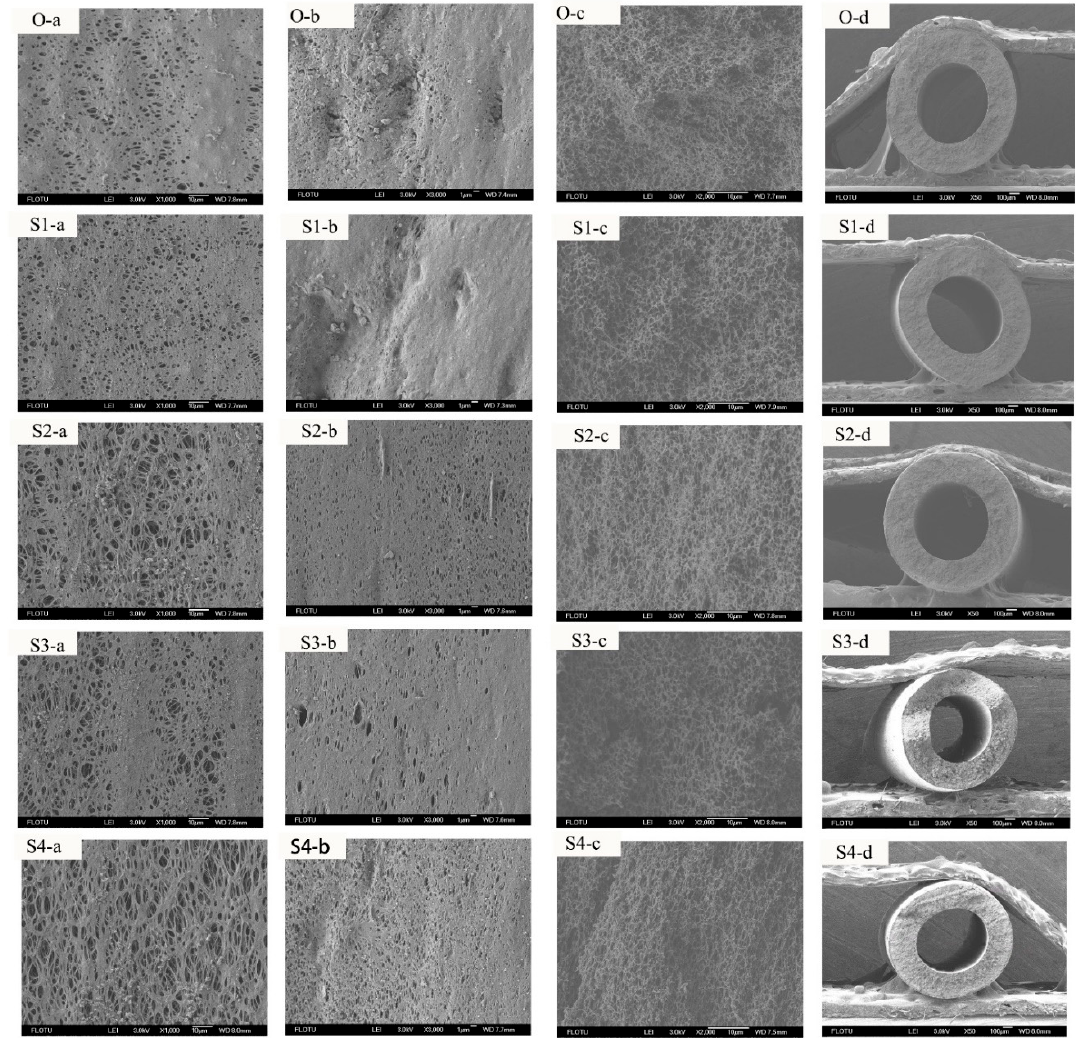
Figure 3. The scanning electron microscope (SEM) photos of the inner surface, the outer surface, cross-section (along the stretching direction), and the whole cross-section of the membrane samples stretched with different stretching ratios. In the figure, a , b , c , and d represent the inner surface, the outer surface, the cross-section (along the stretching direction), and the whole cross-section of the hollow fiber membrane samples, respectively.